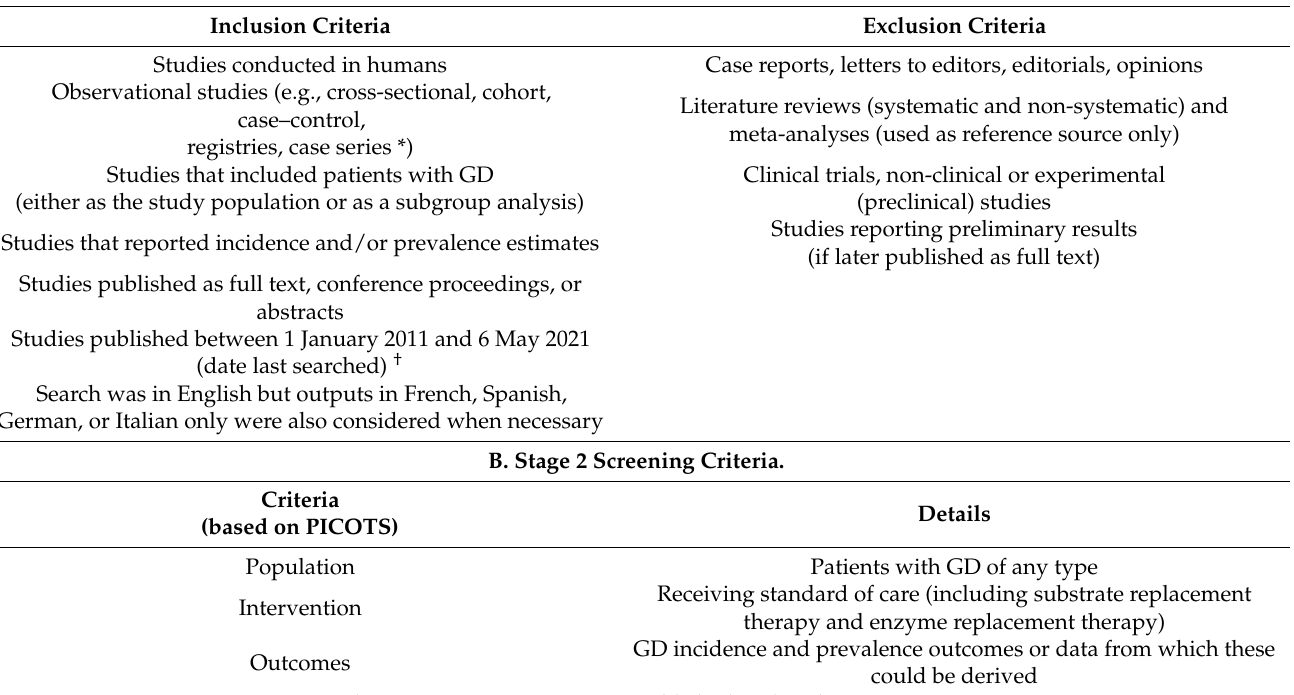
Table 1. Publication eligibility